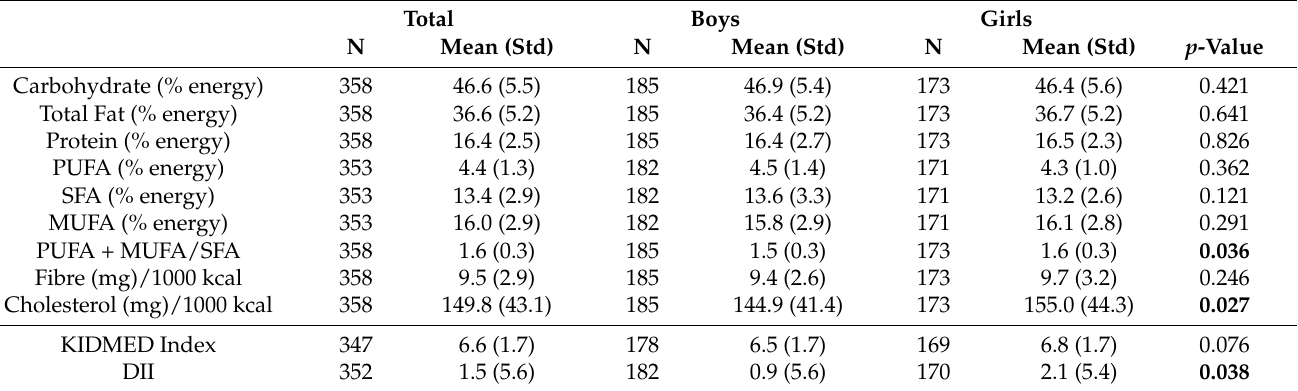
Table 2. Nutrient intake and diet quality by